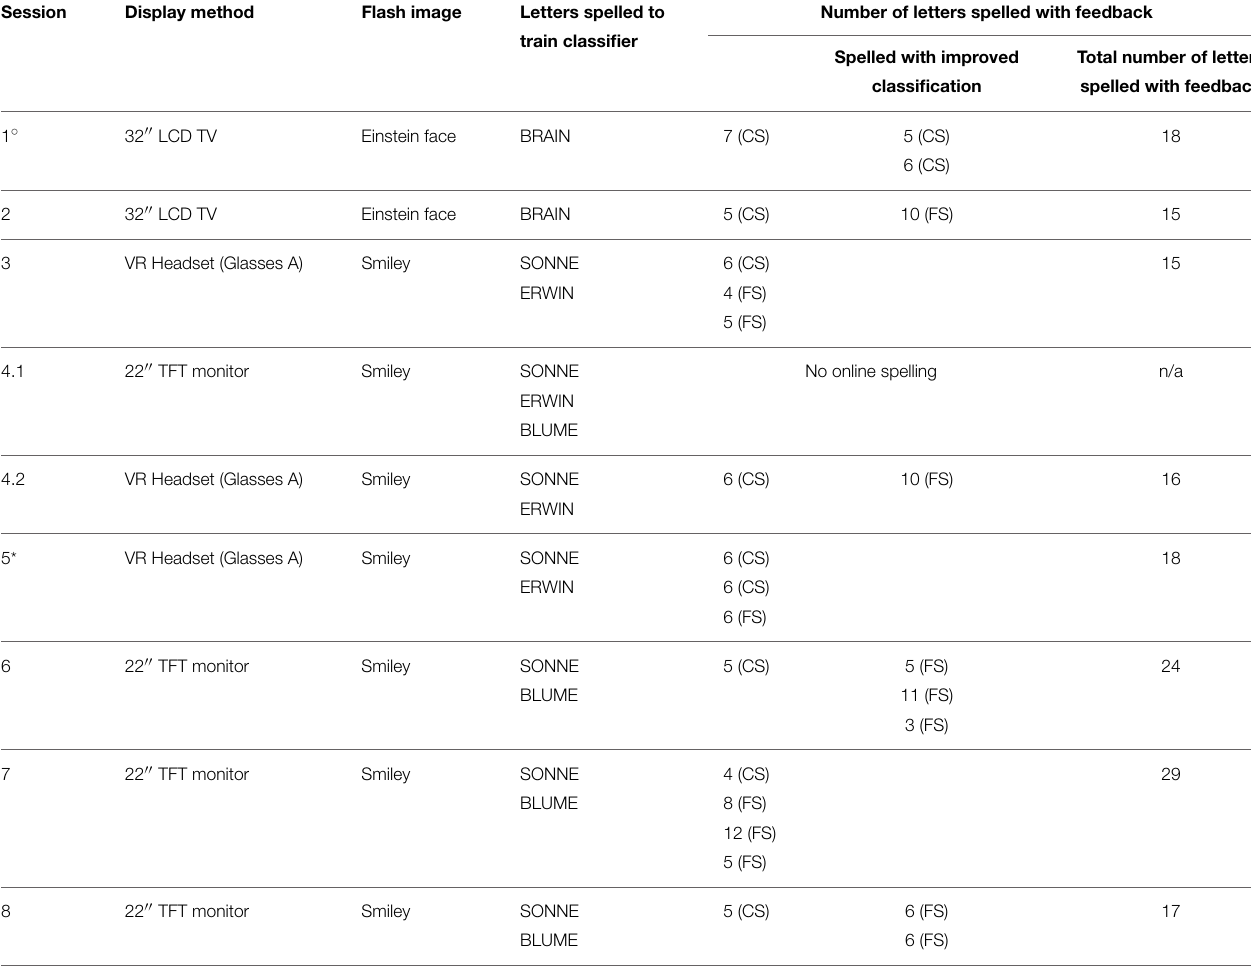
TABLE 1 | Overview of sessions performed by the participant in LIS. Session Display method Flash image Letters spelled to Number of letters spelled with feedback train classifier Spelled with improved Total number of letters classification spelled with